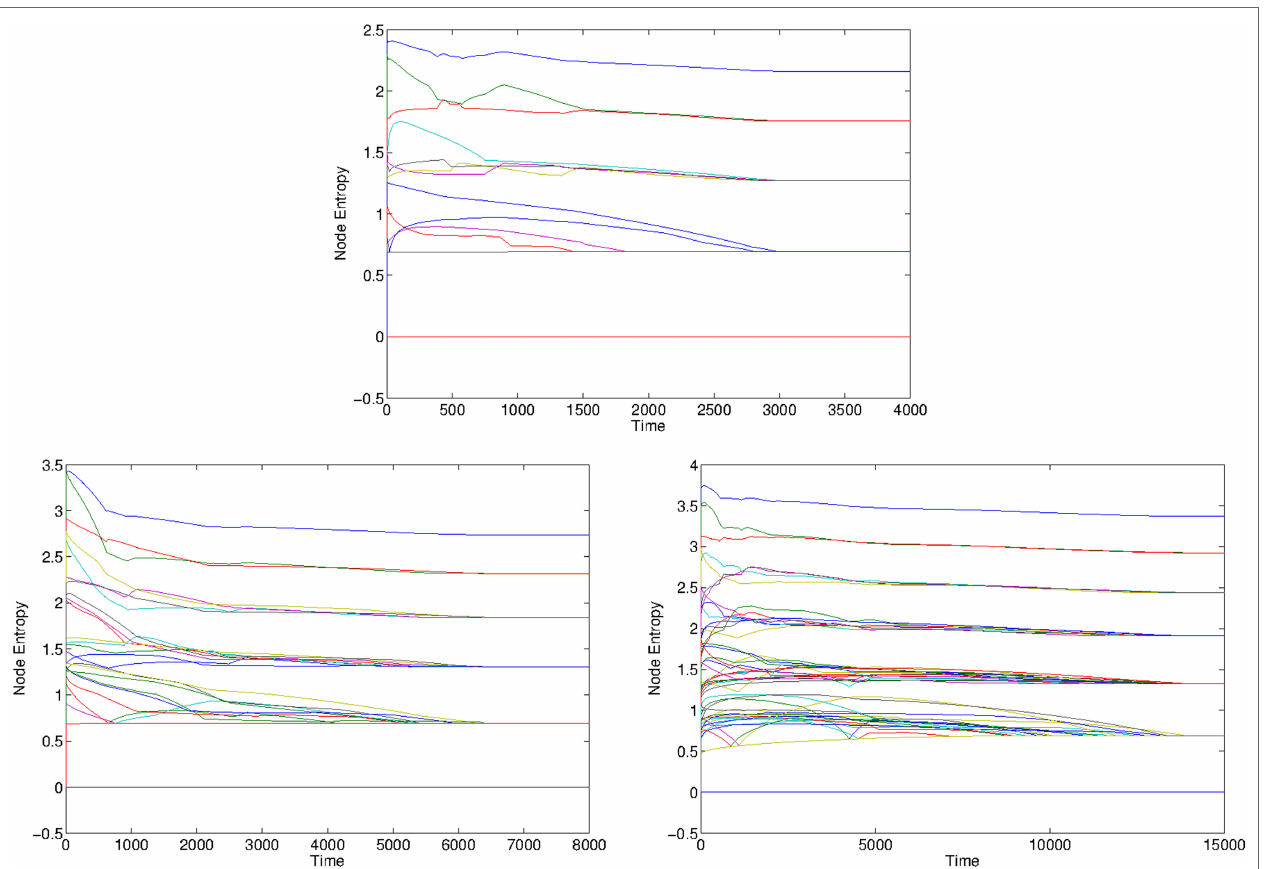
FIGURE 4 | Graph Entropy for the tree circuit of Figure 2 for L =5 (top), L =6 (bottom left), and L =7 (bottom right), in the case of DC generator, with V 0 =20V . The initial configurations are chosen at random. We observe the emergence of L layers of entropy, showing that the system self-organized in order for the nodes in each layers to have equal entropy.